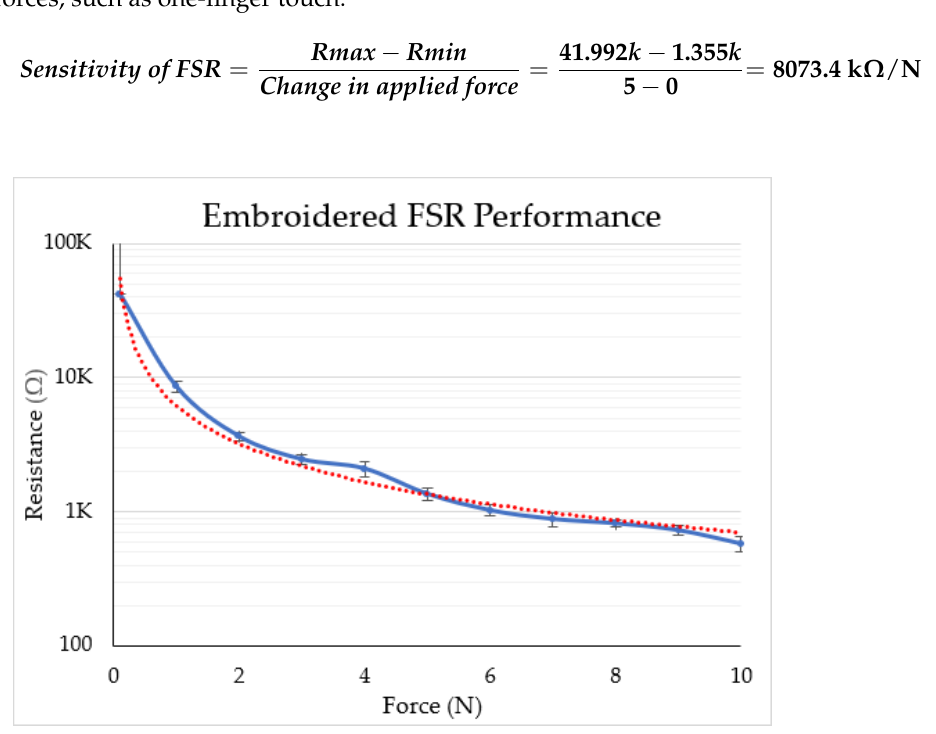
Figure 6. Sensitivity of the e mbroidered FSR up to 10 N.